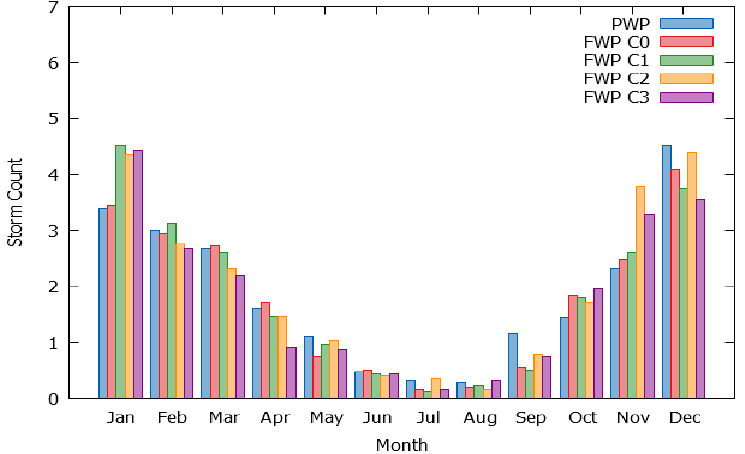
Figure 12. Comparison of present (PWP) and future (FWP-C0–C3) storm count at West Gabbard.